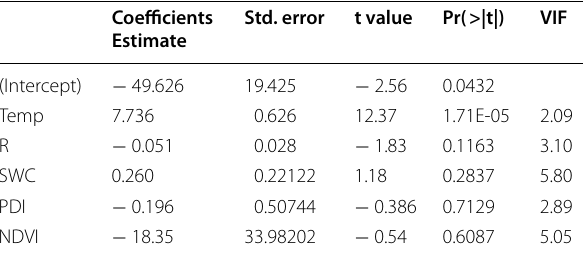
Table 7 Statistical estimates of the subset regression model for the temporal regression